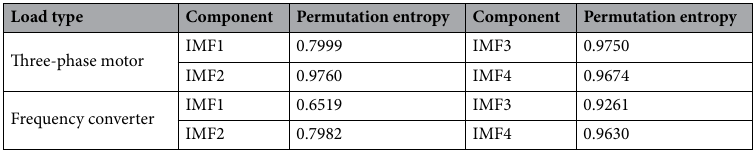
Table 2. Permutation entropy of each IMF component.